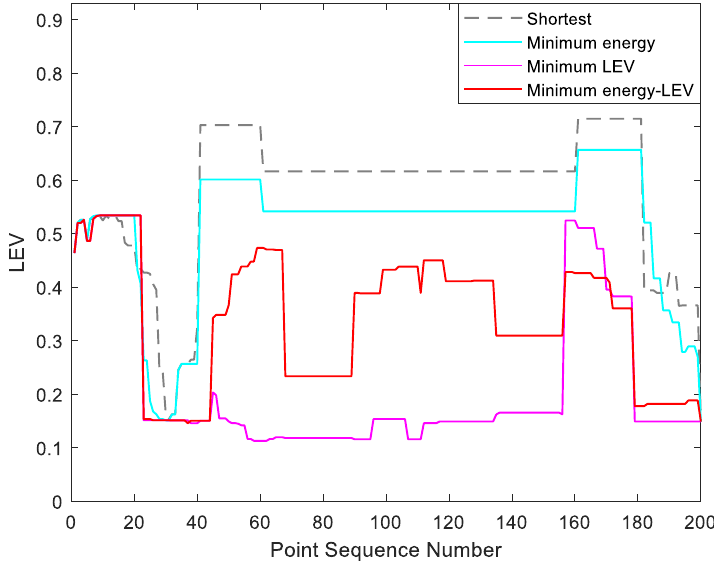
Figure 14. The LEV in the experiments.